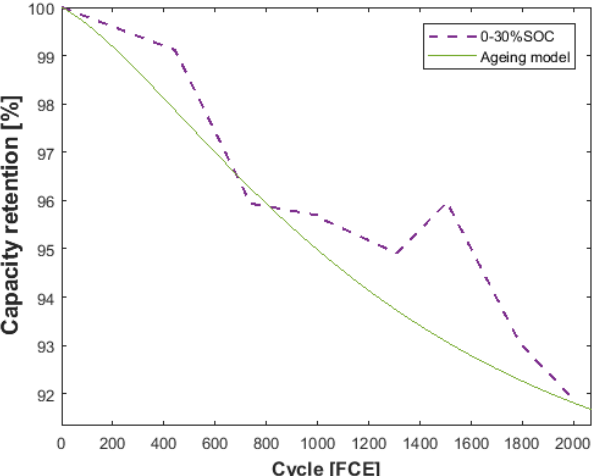
Figure 6. Capacity degradation in 0–30% SOC with 2C charge and discharge for the ageing function together with experimental data in 35 ◦